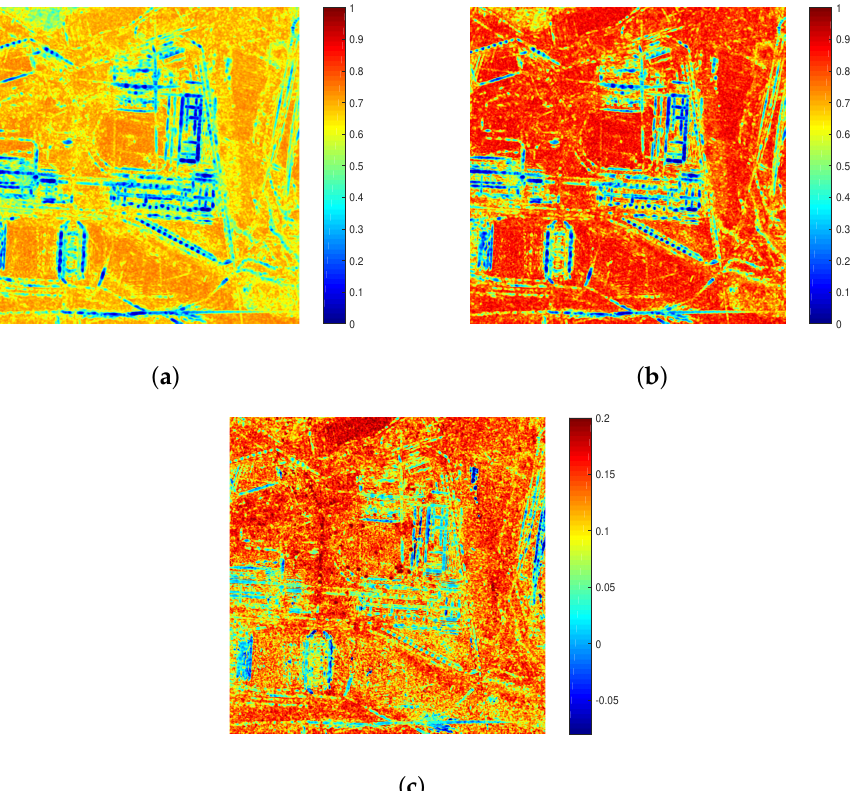
Figure 10. ( a ) MAPE; ( b ) directivity ( Λ ) for Figure 4a; and ( c ) difference in MAPE and Λ . The start position of sub-aperture also affects the interpretation of the target scattering mechanism.